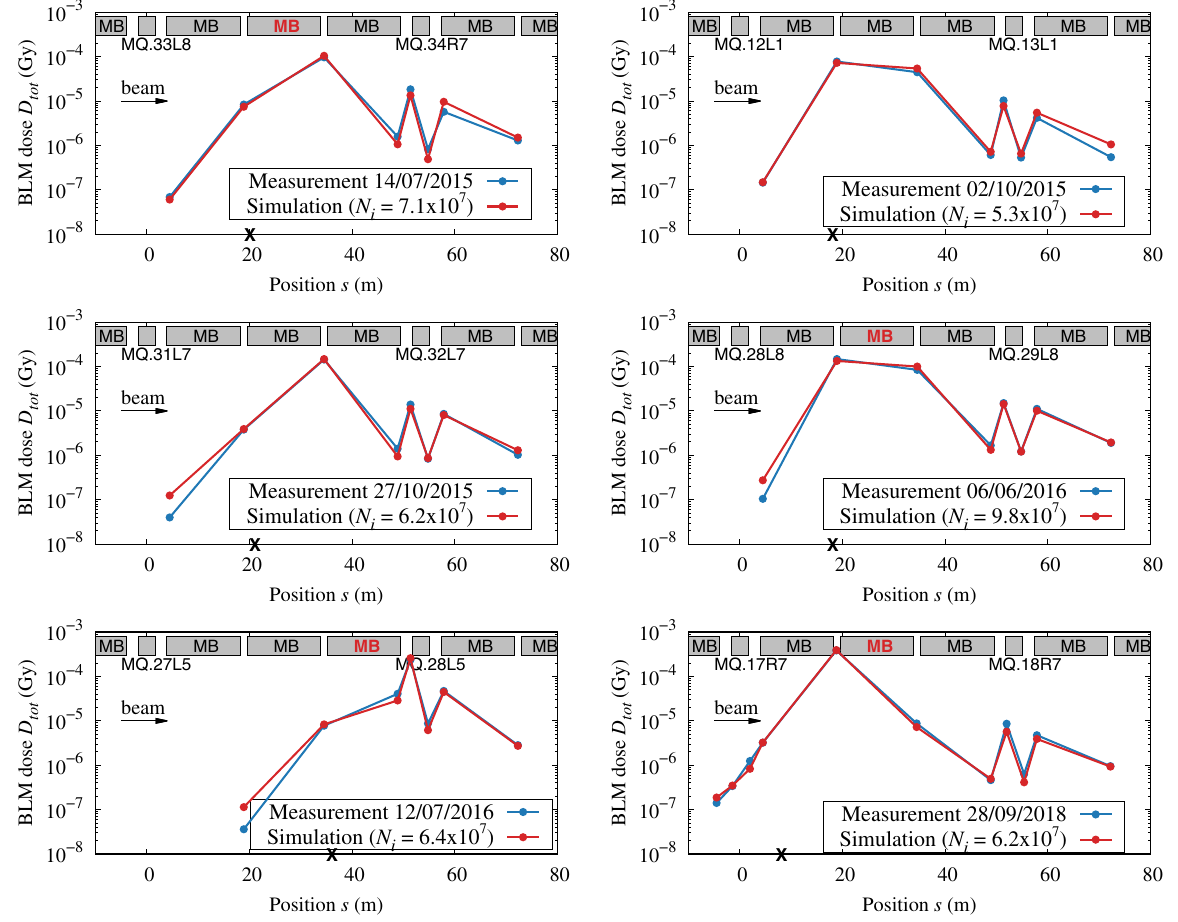
FIG. 5. Comparison of measured and simulated BLM dose patterns along LHC arc cells for dust-induced loss events in run II physics operation at 6.5 TeV. In four out of the six cases a dipole quench occurred (labels of dipoles which quenched due to showers are in bold red). The simulated patterns were scaled according to Eq. (1) to obtain the best match with the measurements. The scaling factors, which represent estimates of the inelastic proton-dust particle collisions, are indicated in the labels. The data points are connected by lines to guide the eye. The estimated s location of the dust particles is identified by “ x ”